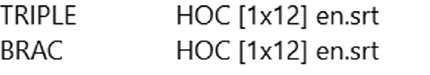
Figure 1: SRT Manager, acronym with